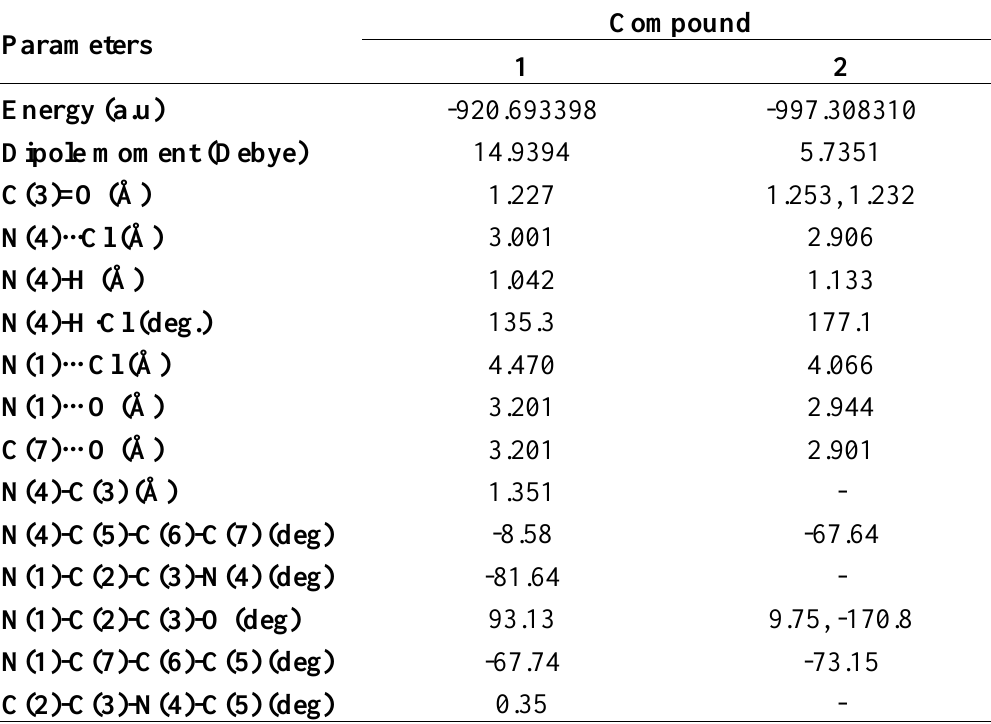
Table 1 . Selected parameters of investigated compounds ( 1 ) and ( 2 ) estimated by B3LYP/6-31G(d,p)